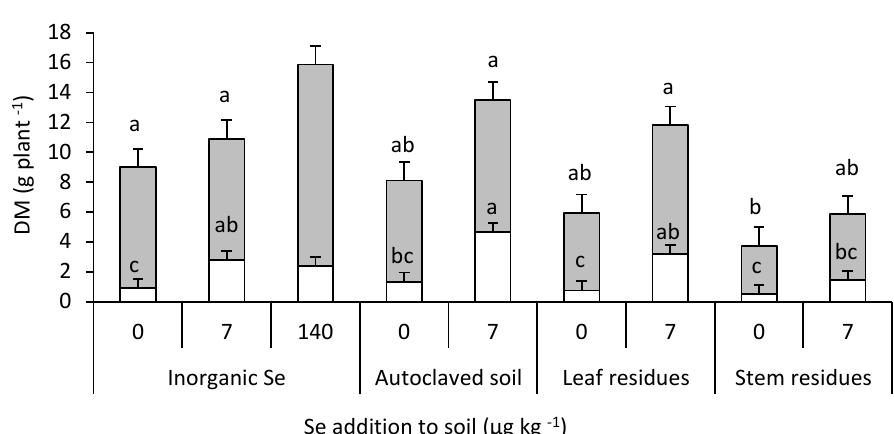
Fig.1. Dry matter (g plant -1 ) of seeds and the silique walls of B. napus L . plants at the seed filling stage grown in soil treated with inorganic Se (0, 7 and 140 µg kg -1 soil), organic Se (leaf and stem residue, 0 and 7 µg kg -1 soil) and in autoclaved soil with inorganic Se (0 and 7 µg kg -1 soil ). Data are expressed as means ± SE, n = 4. The same letter indicates no significant difference among the error bars with the same shading, at p ≤ 0.05. The highest level of Se addition (140 µg kg -1 soil) was not included in this statistical analysis.